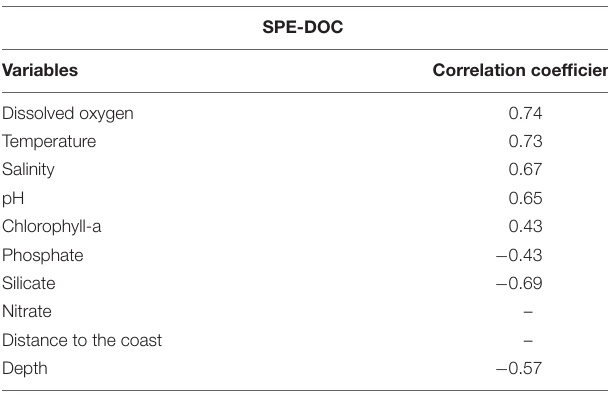
TABLE 2 | Correlation coefficients between SPE-DOC concentration and environmental